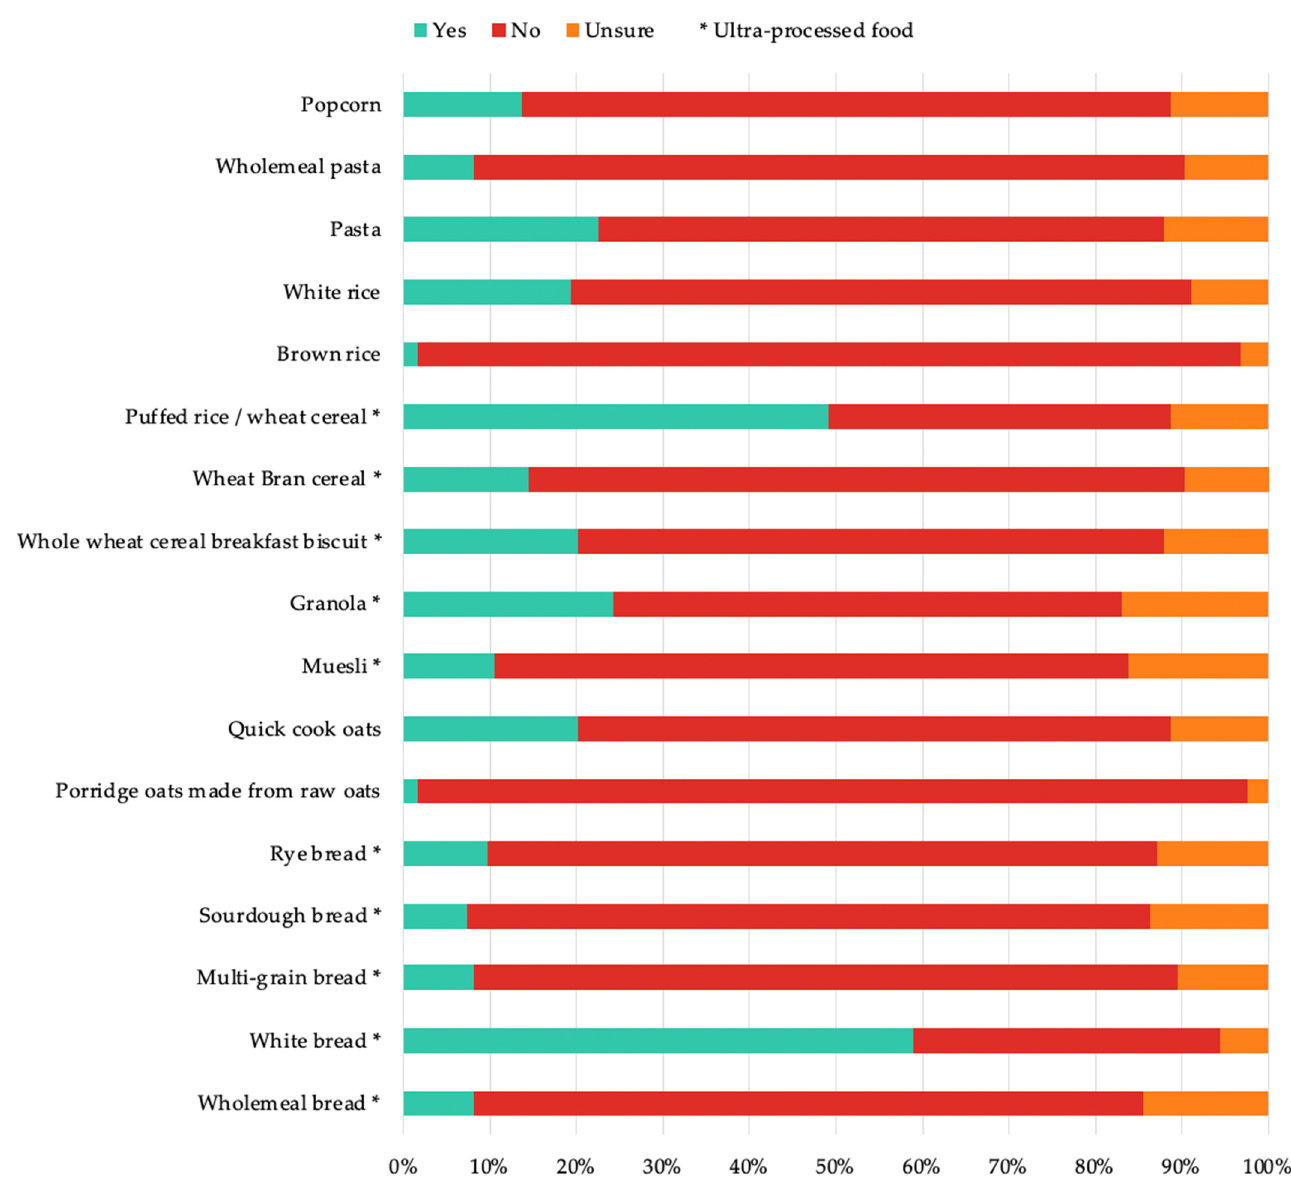
Figure 3. Identification of ultra-processed (NOVA classifications) and non-ultra-processed grain foods by dietitians. A star indicates that a food is classified as ultra-processed.